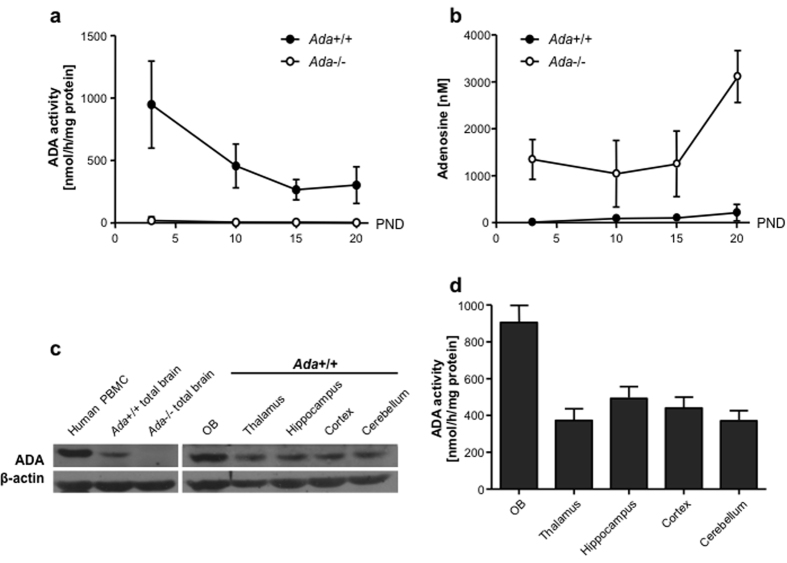
Alterations of the ADA metabolism in the brain of Ada−/− mice.(a) ADA activity/mg of total brain protein measured by HPCE-based analysis in total brain of Ada+/+ (n ≥ 8) and Ada−/− (n ≥ 10) mice at PND 3, 10, 15, 20. (b) Concentration of adenosine levels in total brain protein of Ada+/+ (n ≥ 8) and Ada−/− (n ≥ 10) mice at PND 3, 10, 15, 20. (c) Representative cropped Western Blot analysis for ADA (40 kDa) and β-actin (42 kDa) on brain from Ada+/+ and Ada−/− mice, positive control from human PBMCs. (d) ADA activity/mg of total protein in olfactory bulbs (n = 14), thalamus (n = 11), hippocampus (n = 13), cortex (n = 13) and cerebellum (n = 16) of Ada+/+ mice measured by HPCE-based analysis (average + SEM).